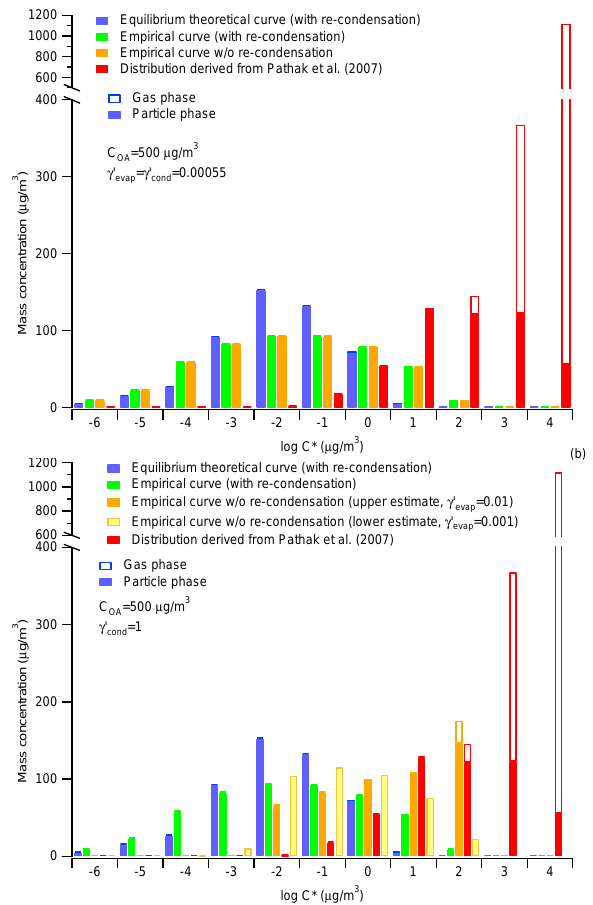
Fig. 15. Volatility distributions derived from α -pinene SOA thermo- grams at 500µgm − 3 aerosol loading in comparison with the distri- bution derived using the parameterisation by Pathak et al. (2007). For case (a) the volatility is substantially underestimated due to the thermogram being significantly far from both the equilibrium and the empirical calibration curves region, while in (b) the deviation using the calibration curve approach is partly due to significant re- condensation. Calculations for upper and lower estimates for re- condensation are included for case (b)